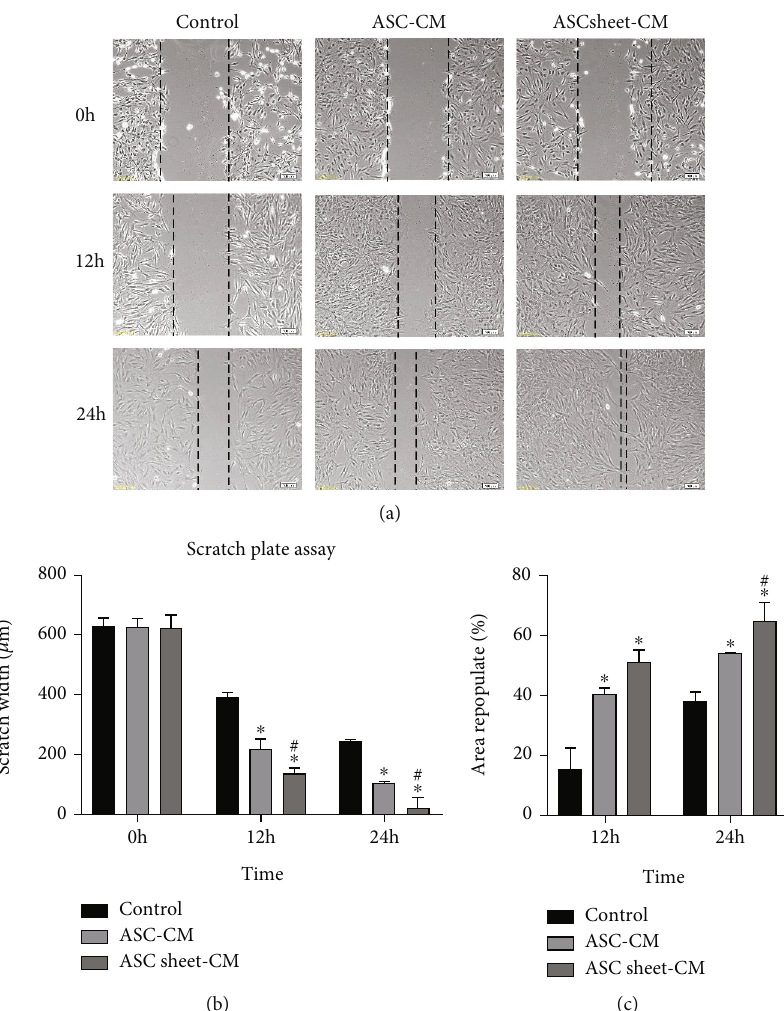
Figure 6: E ff ects of ASC-CM and ASC sheet-CM on the migration of ECs in scratch plate assay. (a) Representative images of the ECs scratch wound assay at 0h, 12h, and 24h. Scale bars: 100 μ m. (b) The widths of the scratches at 0h, 12h, and 24h. (c) The rate of area repopulation at 12h and 24h. ∗ p < 0 : 05 , versus the control group; # p < 0 : 05 , versus the ASC-CM group.